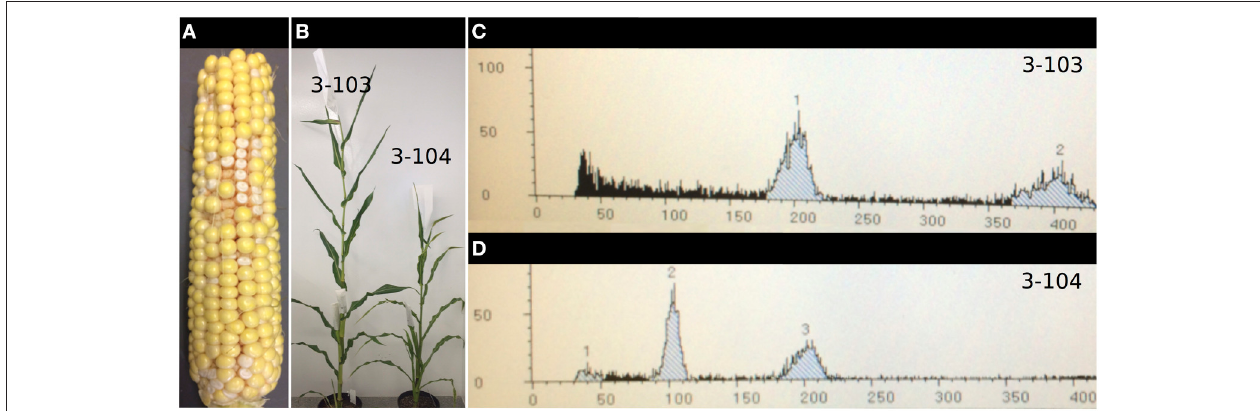
FIGURE 4 | CENH3 -based haploid induction in maize. (A) Photograph of the ear crossed by pollen from individual * A004A:3, which exhibited a 3.6% haploid induction rate (3 haploids found out of 84 embryos). Such elevated levels of induction were always found coincident with low levels of embryo abortion (the white kernels in the photo) scattered around the ear. (B) Progeny from this ear were germinated on media, sampled, and identified by PCR as either haploid or diploid. Based on the PCR calls, a few putative haploid and diploid plants were then transplanted to soil and grown until the diploid plants were shedding pollen. Putative haploids (such as plant * A004A:3-104, right) were male and female sterile. They were also shorter and had thinner leaves than the putative diploids (such as plant * A004A:3-103, left). (C,D) Adult leaf samples were tested to confirm ploidy status. The diploid 2N peak was set at 200 units ( X-axis ) by adjusting the gain while running cells extracted from a known diploid plant through the flow cube. (C) The sample from the putative diploid plant *A004A:3-103 had a 2N peak at 200 units and a smaller 4N peak at 400 units. (D) The putative haploid plant *A004A:3-104 had a 2N peak at 100 units and a smaller 4N peak at 200 units. The image in (D) is representative of the histograms found for all putative haploids.